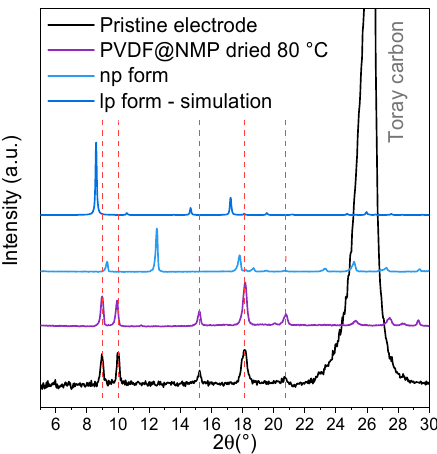
Figure 4. Comparison of XRD patterns (Cu-K α ) of pristine electrode (black) and various forms of MIL-53 powders (violet: MIL-53 with PVDF@NMP dried at 80 °C; blue: np form; dark blue: lp form).